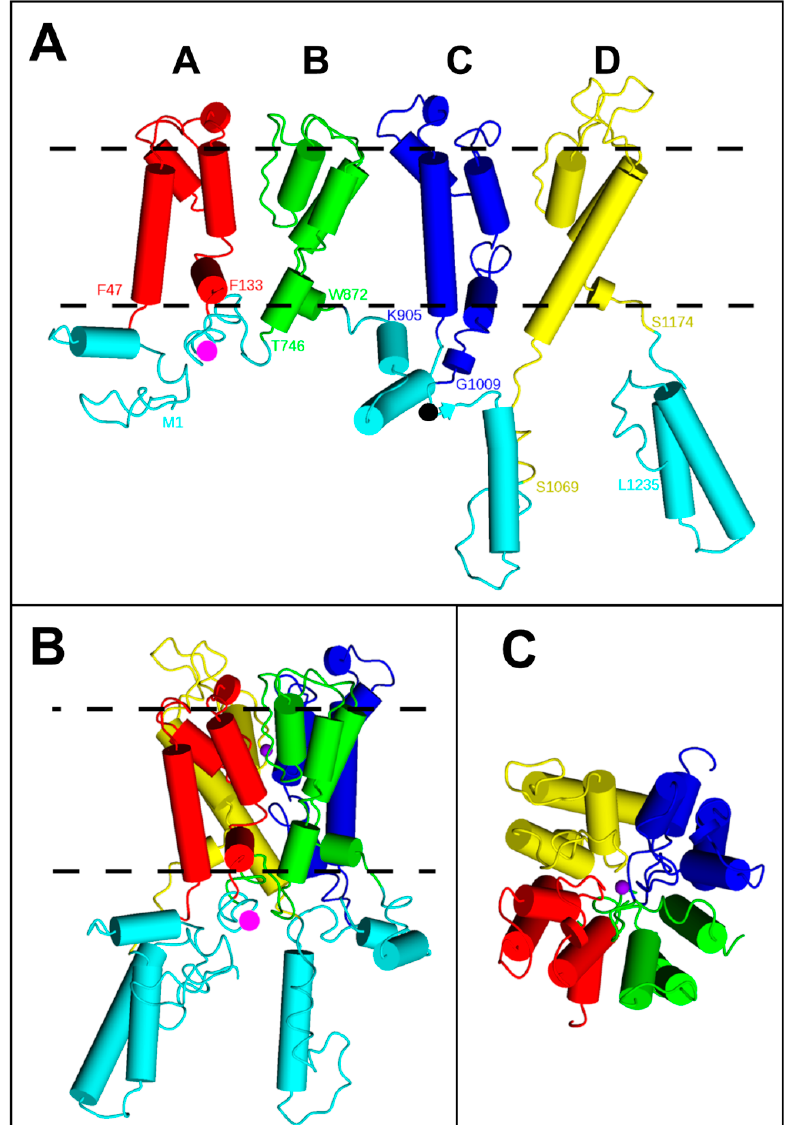
Figure 1. Structure of a Trk1[ Δ LHL] monomer. ( A ) Schematic linear representation of a complete model of a Trkl monomer without the “Long Hydrophilic Loop” (LHL, residues 137–746) that is located between MPM domains A and B. ( B , C ) MPMs are arranged around a central pore; ( B ) side view; and ( C ) top view from the extracellular side. MPM domains are differently coloured: A: red, B: green, C: blue, and D: yellow. The same colour code is used in all the following figures. Terminal residues and residues at the membrane/cytosol borders are labelled with residue number in ( A ). N- and C-terminal stretches and intracellular loops are shown in cyan. Magenta dots in ( A , B ) indicate the position of LHL. The position in which GC was inserted into the third intracellular loop between MPMs C and D (G1010/GC/E1011, see results) is indicated by the black sphere in ( A ). The dashed lines in ( A , B ) indicate the plasma membrane. The violet sphere in ( C ) shows a potassium ion in the pore. N- and C-terminal regions as well as intracellular loops were modelled ab initio or using YASARA. For more details, see Section